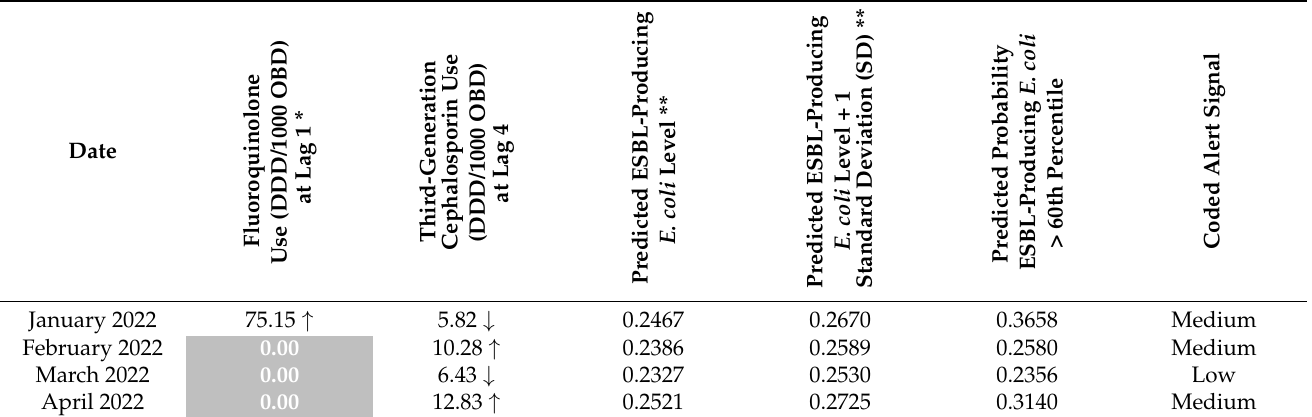
Table 4. What-if threshold logistic model